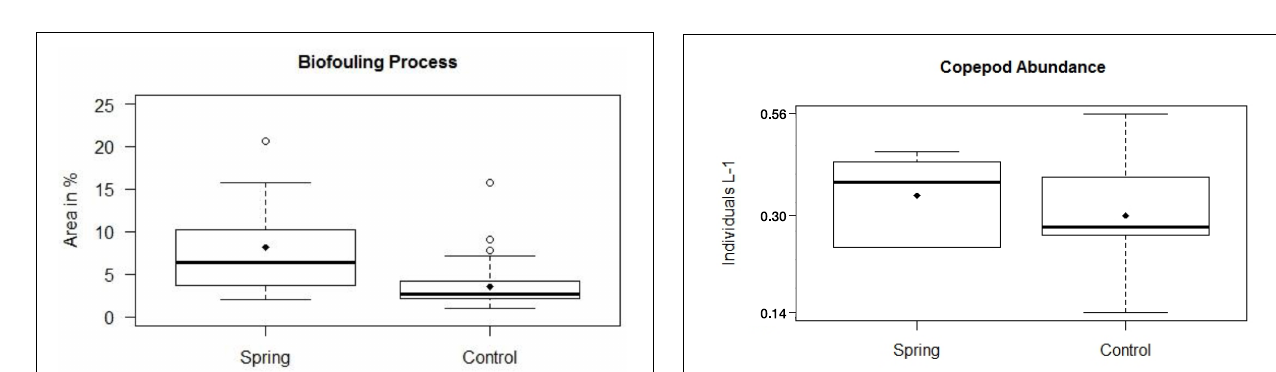
FIGURE 9 | Biofouling processes of 26 settlement panels exposed to a submarine spring and the seawater control section. The biofouling process on the front and the back sides of the settlement panels are illustrated separately. Each data point is one panel in the same distance to the submarine spring as in the field experiment.